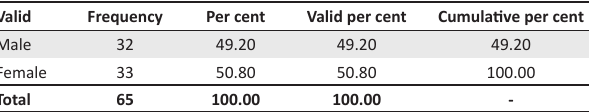
TABLE 2: Frequencies of participants’ gender.